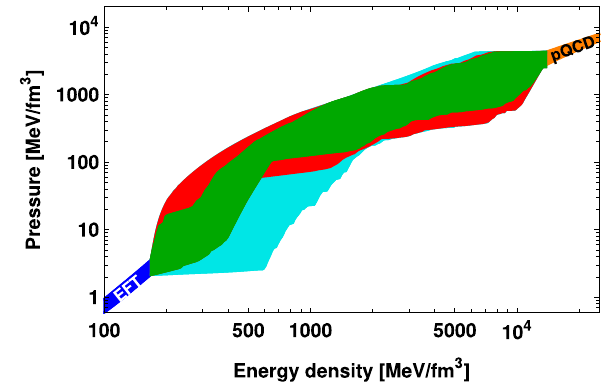
Fig. 4 The band spanned by polytropic interpolations of cold QCD EOS between the low density (EFT) and high density (pQCD) results. Following